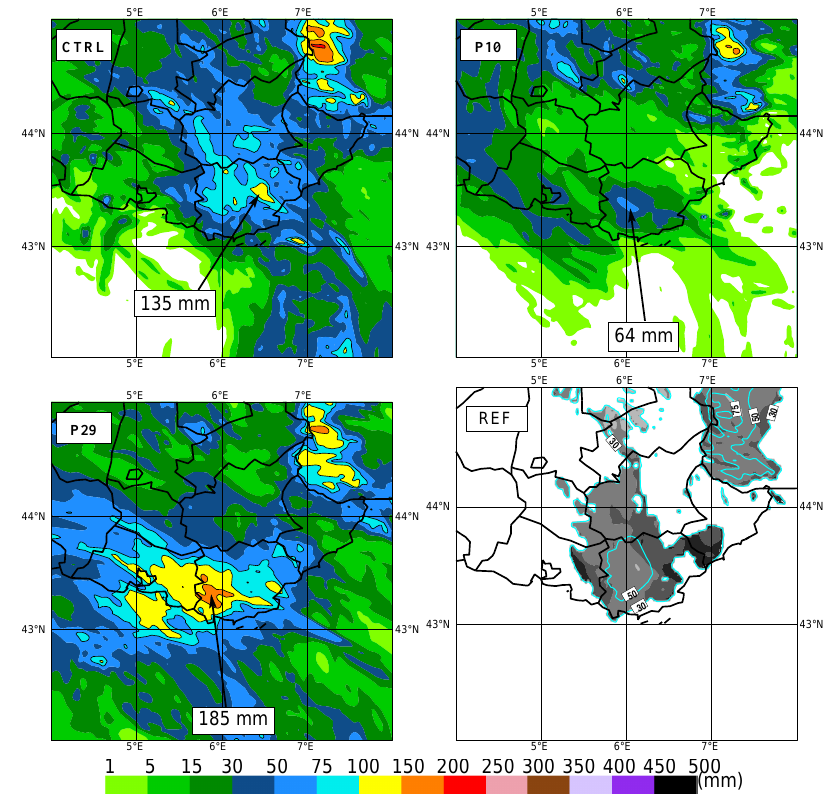
Fig. 6. Var case 24-h accumulated simulated precipitation for the REF convective-permitting ensemble experiment. The run is valid for 16 June 2010 at 06:00UTC and starts on 15 June 2010 at 00:00UTC. Precipitation maxima are pointed out over the Var department. The last panel shows the 24-h accumulated ensemble-mean (solid line) and the normalised spread (shading). The spread is not shown for precipitation below 30 mm day − 1 .